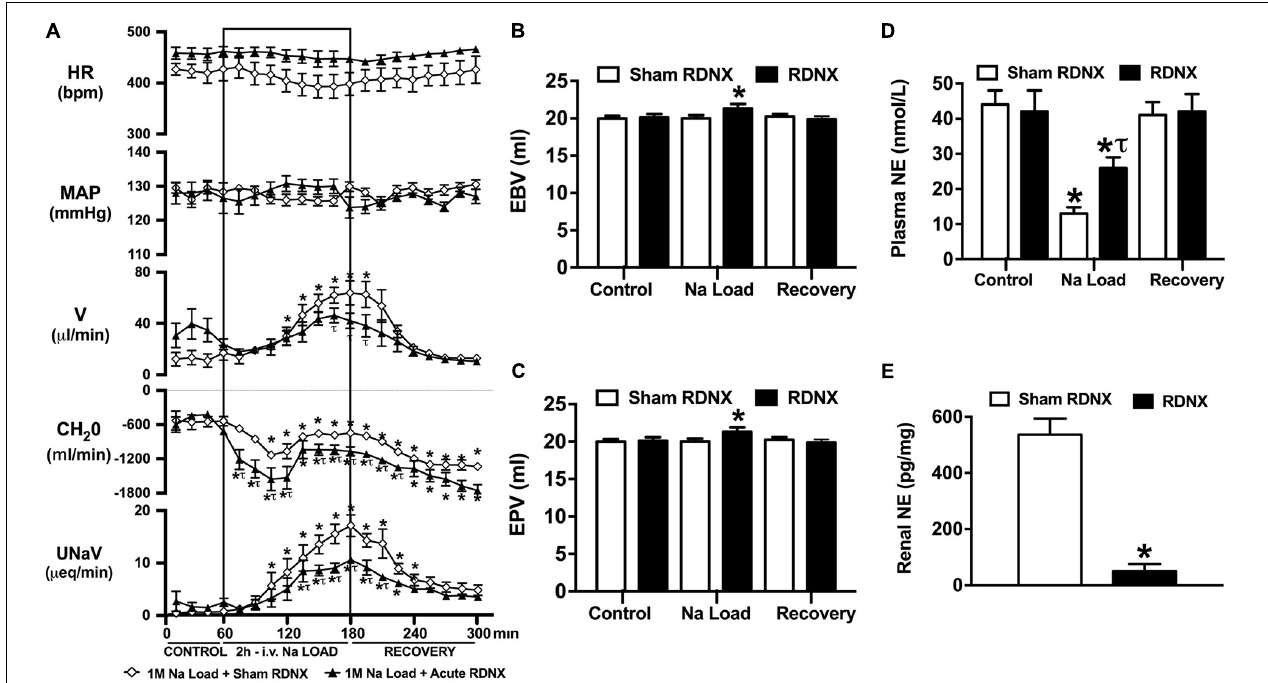
FIGURE 3 | Effect of acute renal denervation (RDNX) on the cardiovascular and renal responses to an acute 1M NaCl infusion (A) Cardiovascular and renal responses, (B) Estimated blood volume (ml), (C) Estimated plasma volume (ml), and (D) Plasma norepinephrine content (nmol/L) during a 1-h control isotonic saline infusion (20 µ l/min), a 2-h 1M NaCl infusion (20 µ l/min) and a 2-h recovery period of isotonic saline infusion (20 µ l/min) in sham or acutely RDNX conscious male Sprague Dawley rats, (E) renal NE content (pg/mg). HR = heart rate (bpm), MAP = mean arterial pressure (mmHg), V = urinary flow rate ( µ L/min), CH 2 O = free water clearance, UNaV = urinary sodium excretion ( µ eq/min). Data are presented as mean ± SEM, N = 6/group. * p < 0.05 vs. group baseline value in last 15-min of the control saline infusion. τ p < 0.05 vs. respective sham RDNX group